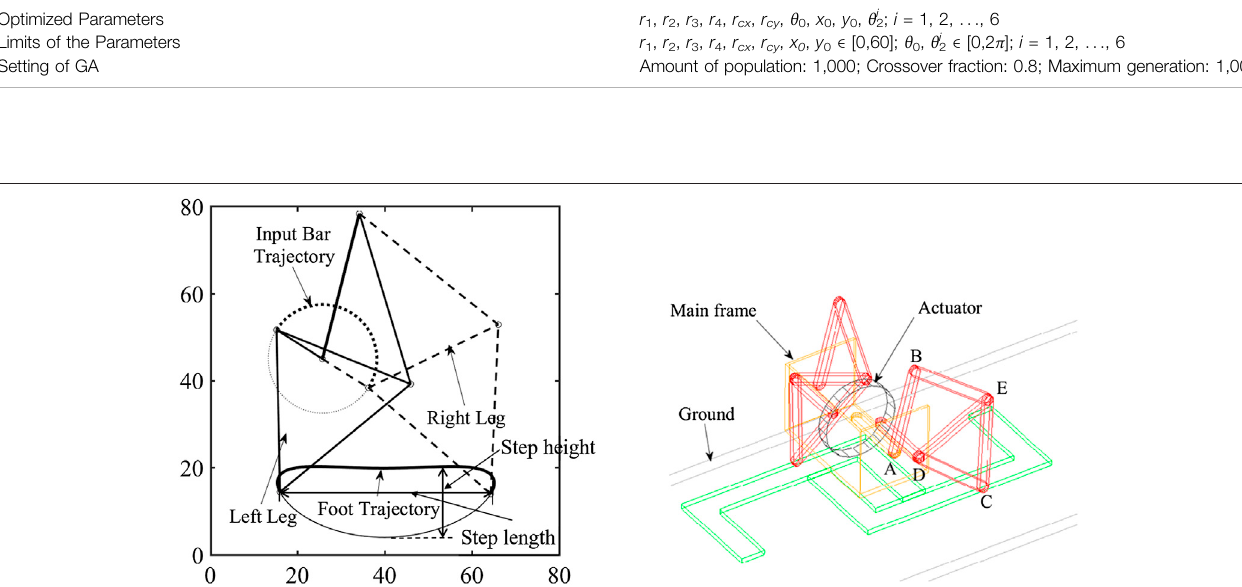
TABLE 1 | General Setting of the optimization. C i d ( i = 1 – 6) (mm)